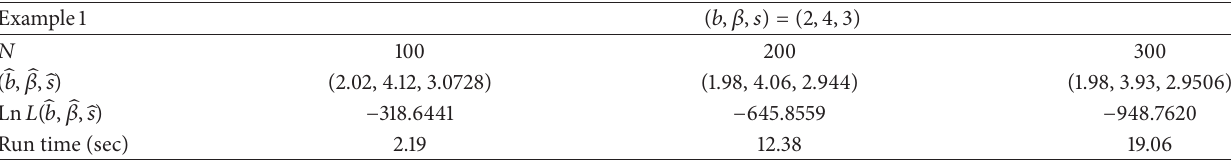
Table 1: Experimental result for Example1.